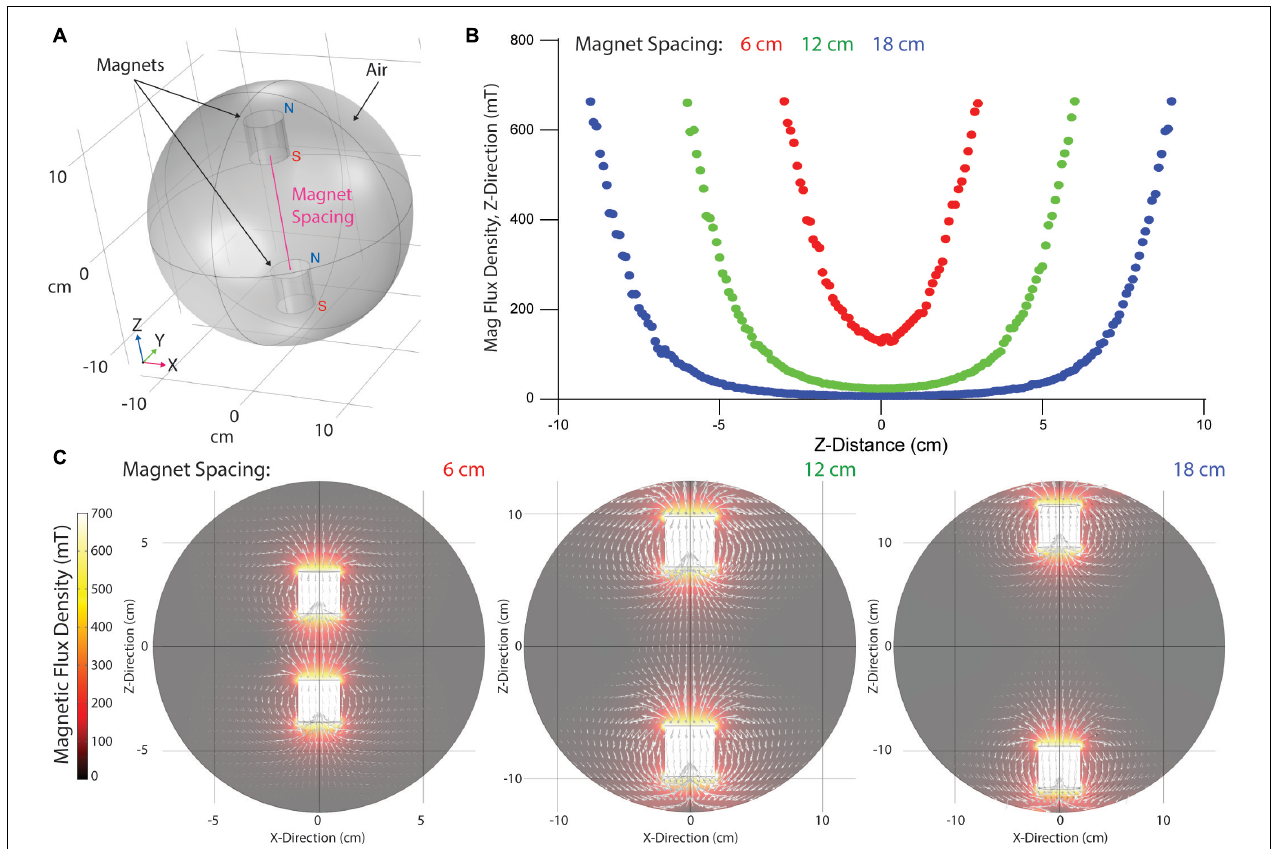
FIGURE 2 | Computational modeling of applied magnetic fields within gelation chamber. (A) Model geometry with two cylindrical magnets within a spherical air area. Magnet orientation with North in the positive Z-direction. (B) Quantified magnetic field strength in the Z-direction of the magnet axis over a range of magnet spacings. (C) Visualization of magnetic flux density and field lines (white